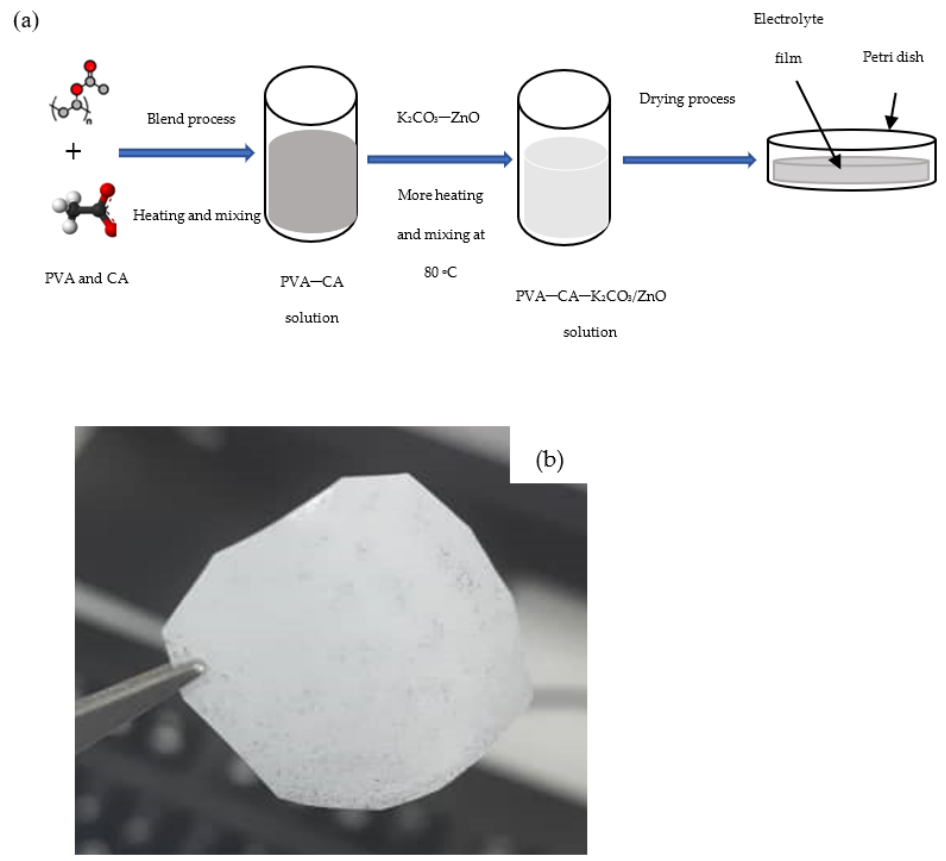
Figure 1. ( a ) Illustration steps for the preparation of SPEs, and ( b ) typical photo of the PVA–CA– K 2 CO 3 /ZnO-NPs SPE film with the composition of 10 wt % ZnO-NPs. Table 1. Variations of ZnO-NPs in the PVA–CA–K 2 CO 3 /ZnO SPE composites.